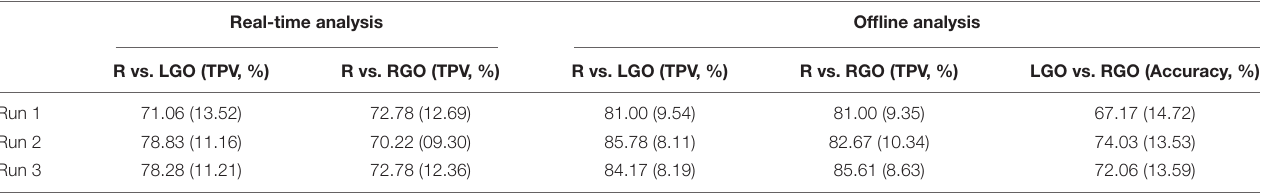
FIGURE 2 | Classification performance for support vector machines (SVMs) trained using the incremental strategy outlined in Figure 1B (A) during real-time neurofeedback training (real-time analysis) and (B) offline analysis of the same data set. R, rest; LGO, imagined left hand gripping and opening; RGO, imagined right hand gripping and opening; TPV, task predictive value. TABLE 1 | Support vector machine (SVM) classification performance for the different classification models. Real-time